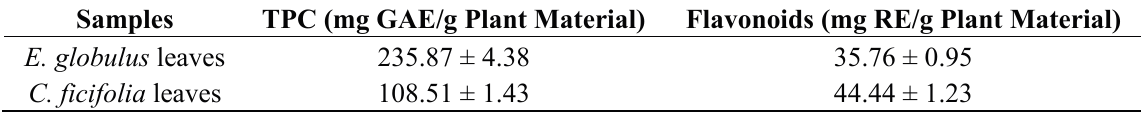
Table 2. The content of total polyphenols and flavonoids in the extracts.